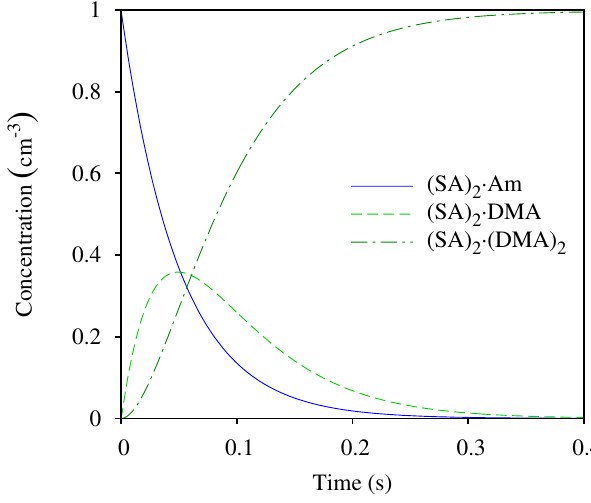
Fig. 2. Reaction of [ ( SA ) 2 · ( Am ) 3 ] + clusters with DMA gas at a pressure of 1 . 2 × 10 − 8 Torr. Blue: modeled concentrations in cm − 3 , red: experimentally observed relative concentrations (Bzdek et al., 2010a).